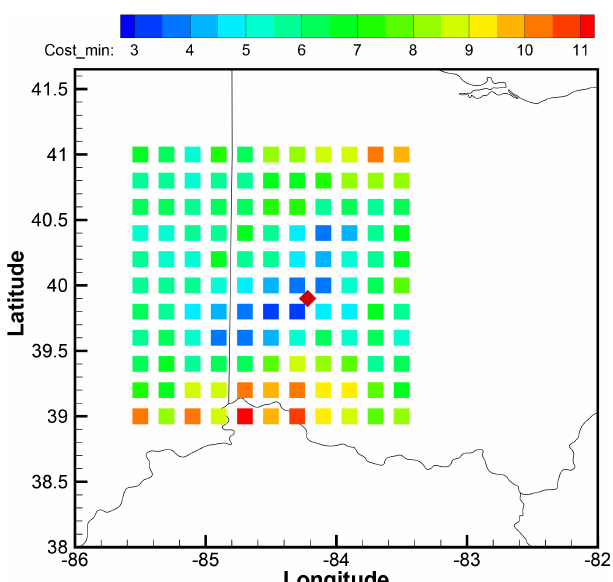
Figure 4. Distribution of 121 candidate source locations for release 2. The minimal cost function at each location associated with an optimal release strength is indicated by color. The cost function defined in Eq. (5) is calculated with f o = 20%, a o = 20pgm − 3 , f h = 20%, and a h = 20pgm − 3 . The actual source location, Day- ton, Ohio, USA, is shown as a red diamond.